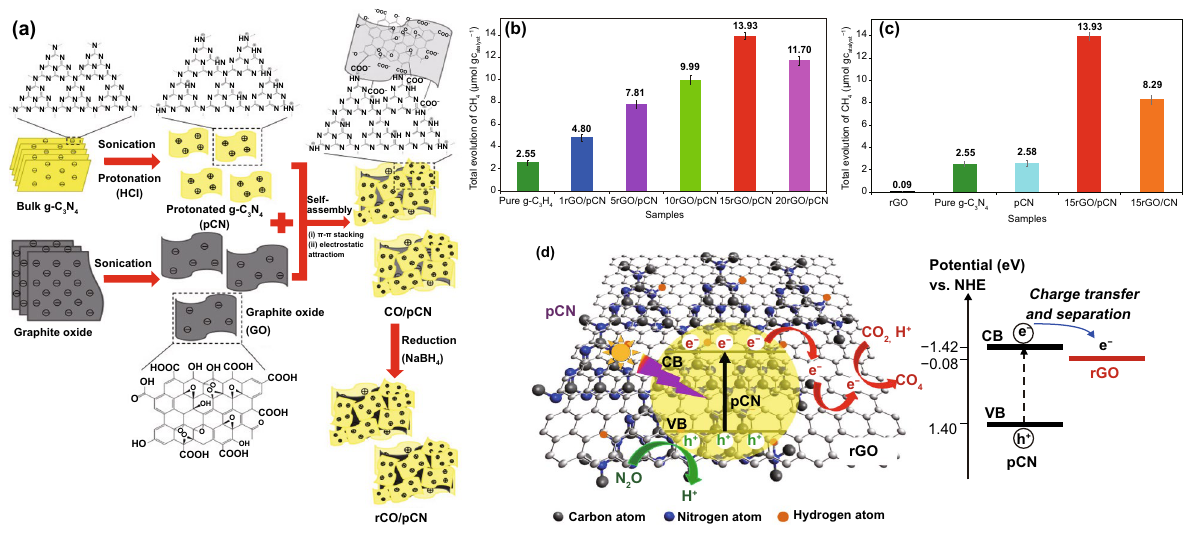
Fig. 29 a Production method of rGO/pCN. b Total production of CH 4 over pure g‑C 3 N 4 and a series of rGO/pCN photo‑catalysts with different rGO contents under vis‑light irradiation for 10 h. c Total evolution of CH 4 after 10 h over rGO, pure g‑C 3 N 4 , pCN, and 15rGO/CN. d Charge transfer and separation process happening in rGO/pCN nano‑composite for CO 2 reduction to CH 4 in the occurrence of H 2 O under vis‑light light‑ ing. Adapted with permission from Ref.